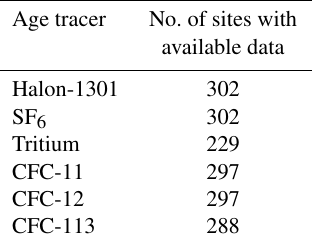
Table 1. Summary of the number of sites at which each age tracer has been determined in this